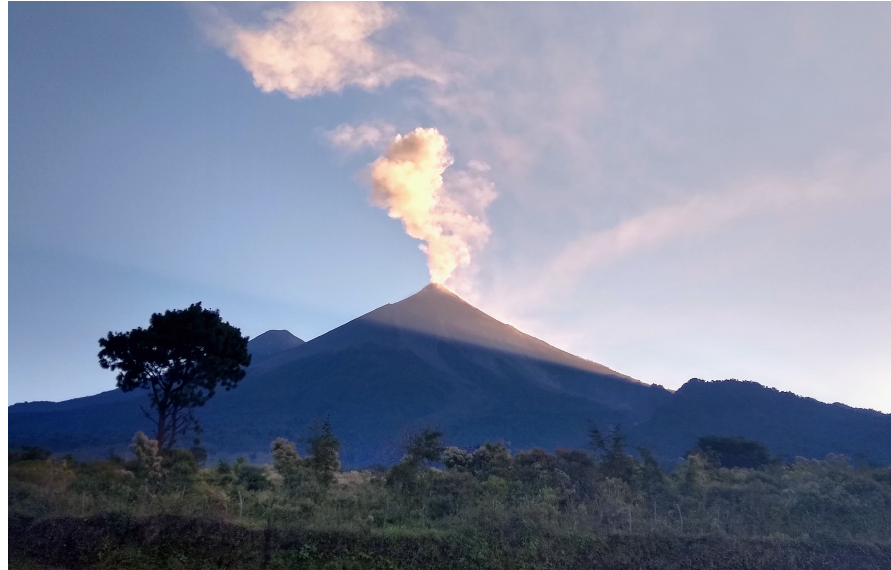
Figure 1. Sunrise over Volca´n de Fuego, from the Ground Control